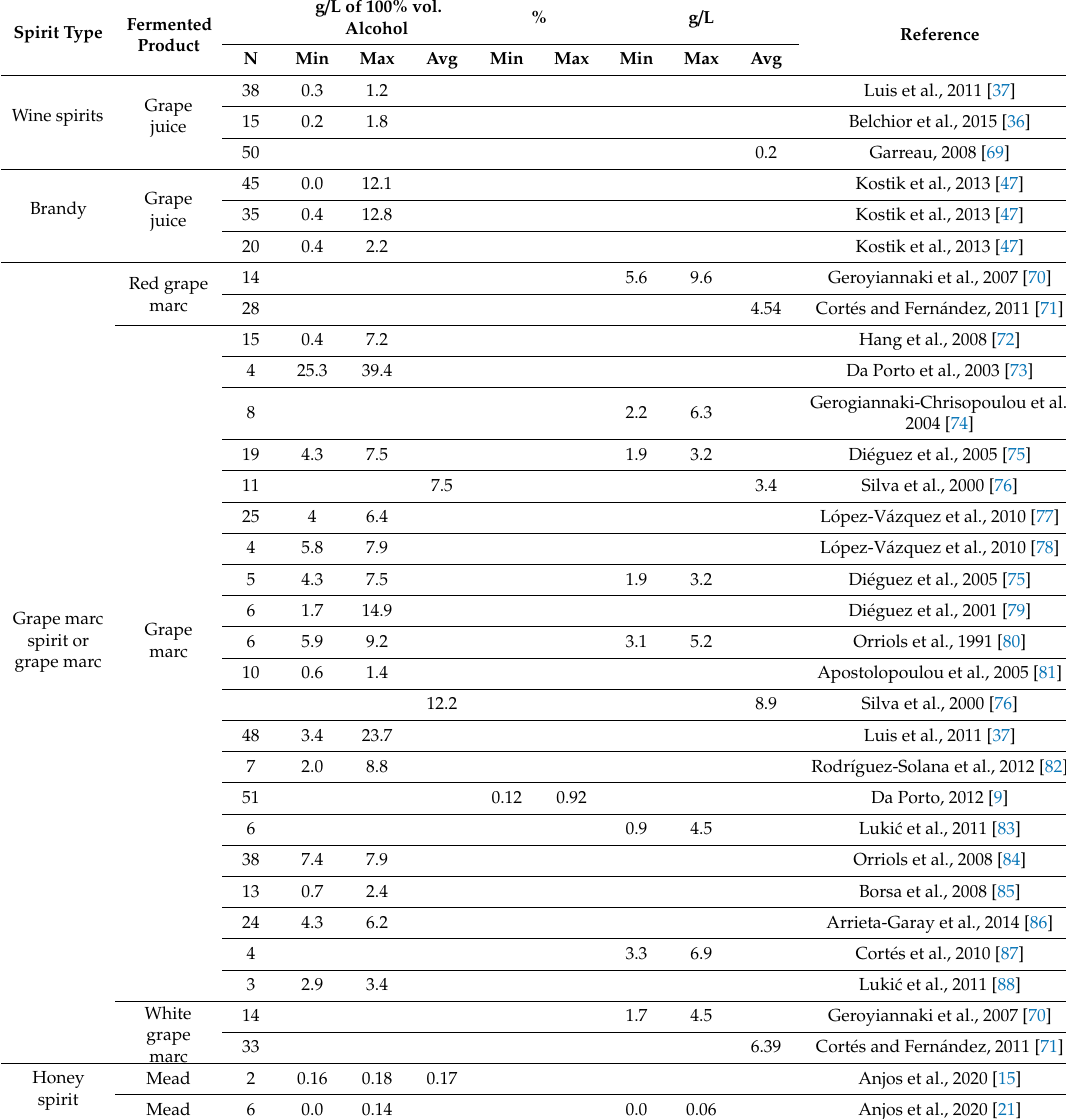
Table 4. Methanol content (in grams per liter of 100% vol. alcohol, % and g per liter) found in wine spirits, brandy, grape marc spirit or grape marc and honey spirit (n-number of samples analyzed; min-minimum value; max-maximum value; avg—average